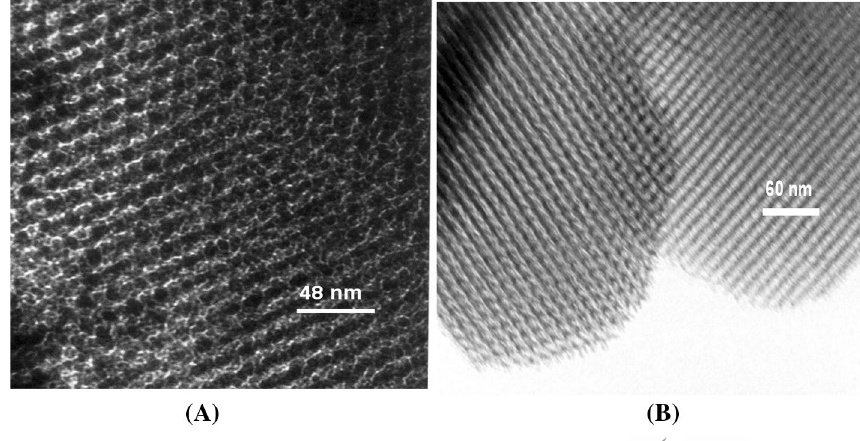
Fig. 2 TEM images of SBA-15 sample; A taken on perpendicu- lar to pore direction and B taken on parallel to pore direction